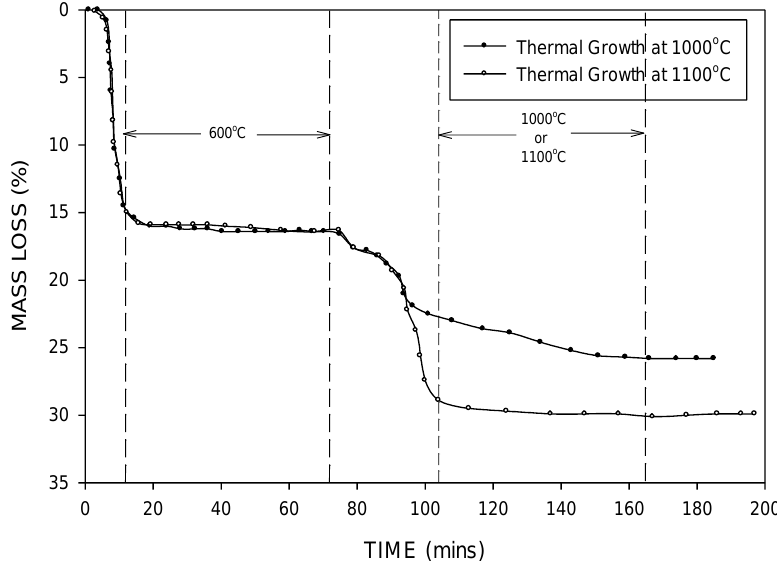
Figure 8. TGA results of mass loss versus time for reduction at 600 ◦ C and thermal growth at 1000 or Figure 8: TGA results of mass loss versus time for reduction at 600°C and thermal growth at 1100 ◦ C for a sample containing 6% coal and 4% 1000 or 1100°C for a sample containing 6% coal and 4% sulphur.